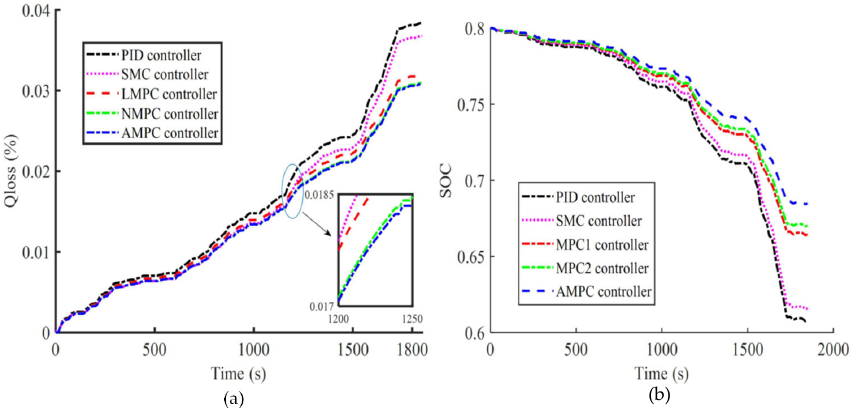
Figure 14. Under WLTC working conditions, the battery (SOHini = 0.9) parameters under the action of each controller: ( a ) battery capacity loss ( b ) SOC. Table 8. Capacity loss value and SOC of battery under each controller after the WLTC (SOHini = 0.9). Controller